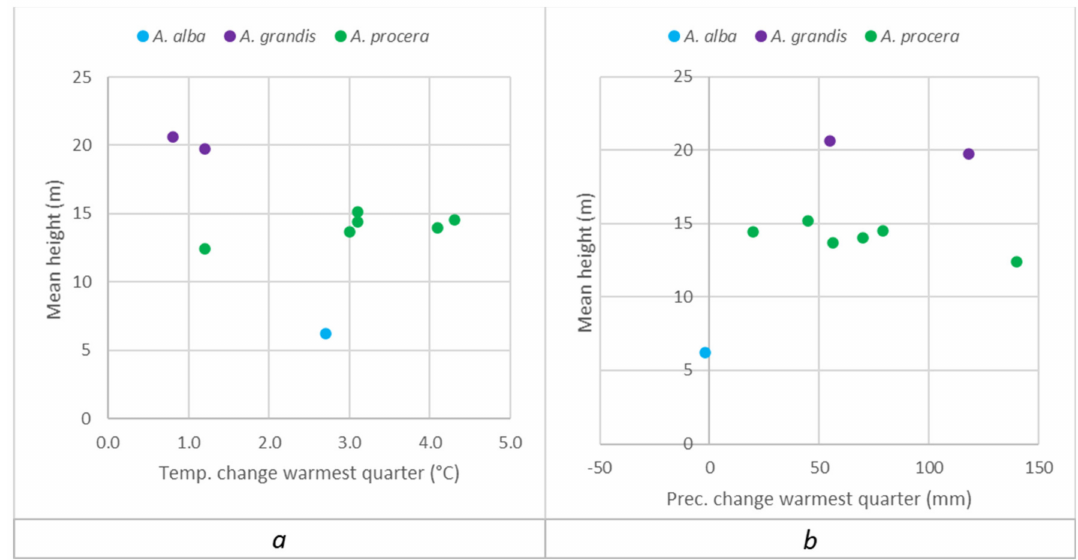
Figure A3. Mean summer temperature ( a ) and precipitation ( b ) change versus mean height of provenances of three species at the age of 32 years, in the trial 219, Dražiˇcky. Note the differences between grand fir, noble fir and the autochthonous standard Adršpach from the Czech Sudeten